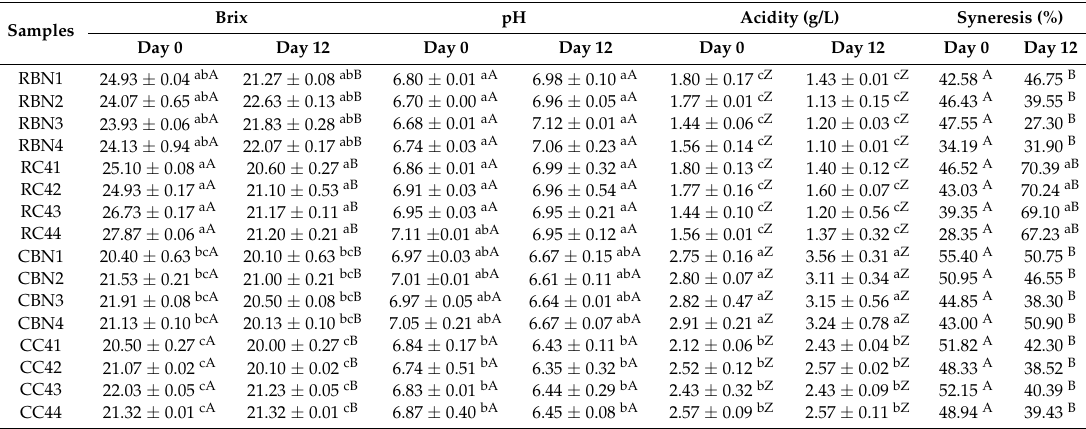
Table 2. Physicochemical properties of dairy dessert systems, 0 and 12 days.